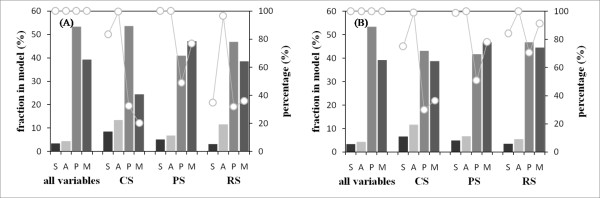
Relation between prediction accuracy and the number of variables included in the model. The fractions of variables included in (A) the internal motion prediction model and (B) the external_short motion prediction model. The histogram shows fractions of each variable category in the model when the variables are divided into four categories according to the feature type (see the Methods section). The plot shows percentages of the number of variables included in a downsized model against the number of variables included in the original model. The fraction of the variable category and percentage of the number of variables are respectively represented on the left and right sides' vertical axes. Although all variables were computed from the original model, the center of the secondary structure (CS), periphery of the secondary structure (PS), and remote area from the secondary structure (RS) were computed from downsized models. The CS, PS, and RS respectively signify categories which classify an amino acid according to the secondary structure (see the Methods section). Furthermore, S, A, P, and M respectively signify the names of feature groups described in the Methods section, and corresponding to secondary structure, ASA, physicochem., and mobility. The value of the Gini index was set to 1.7 in (A) and 0.7 in (B). The external_long prediction model showed similar tendencies to those of the external_short prediction model (data not shown). These results were obtained using the method that implemented psipred and sable.